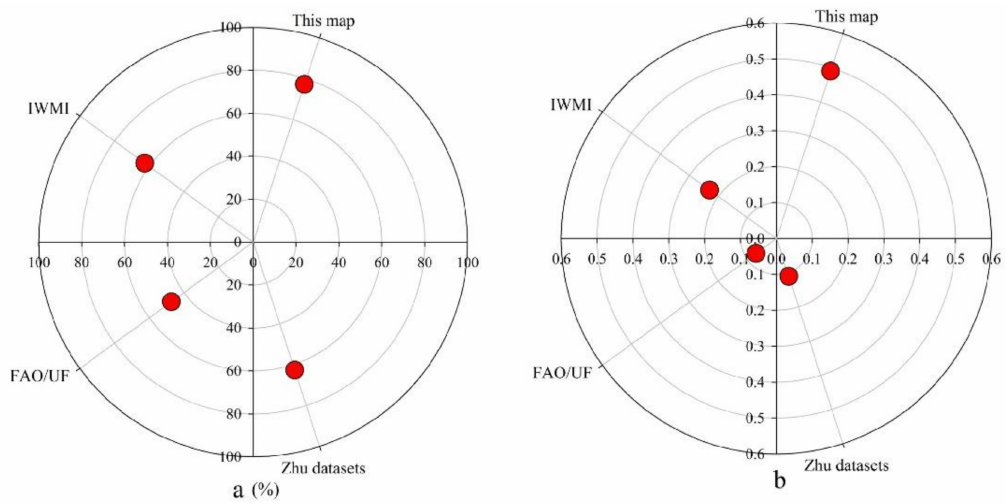
Figure 6. Comparison of the performance of four datasets (this map, IWMI, FAO/UF, Zhu datasets) at 123 field sites. ( a ) overall accuracies (%); ( b ) Kappa coefficients. Table 2. Validation of four irrigation datasets at 123 field